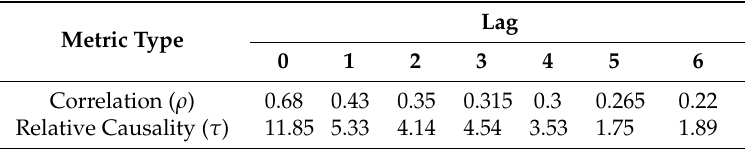
Table 4. Threshold of edges magnitude to construct correlation and causality graphs (percentile of 50% of the empirical probability distribution of causalities and correlations per